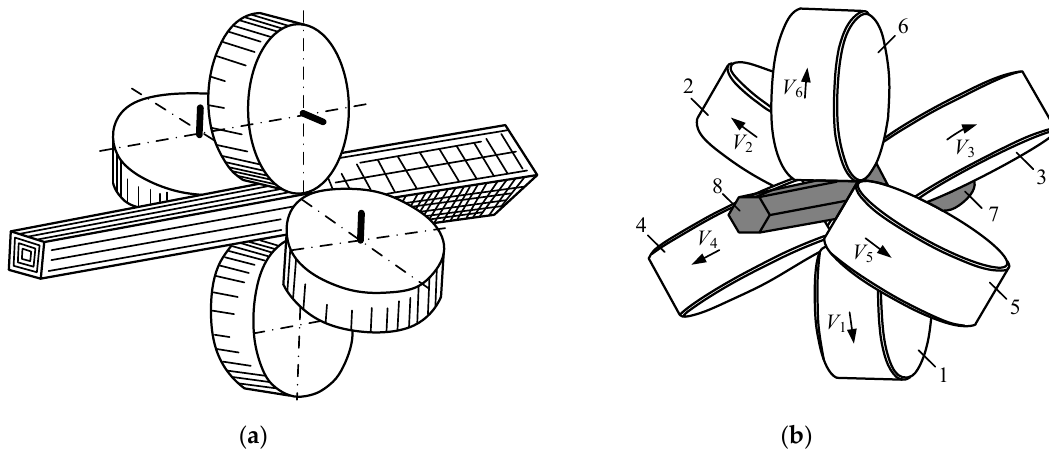
Figure 1. Layout for rolling a square-shaped stock material: ( a ) in four-roll pass; ( b ) in a stand with two three-roll passes.